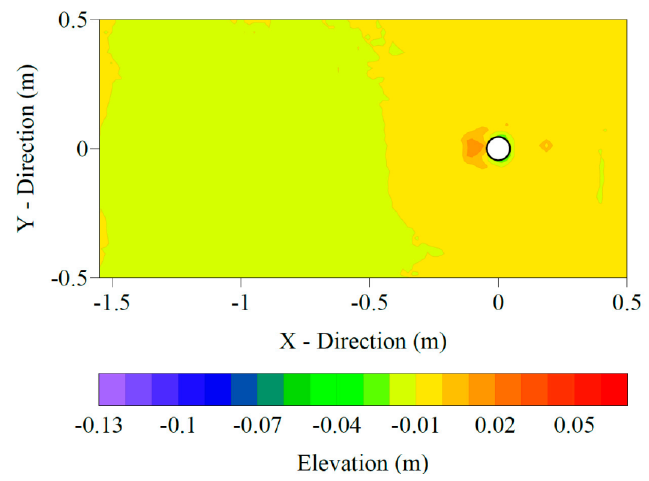
Figure 8. Scour contour plot for the Open